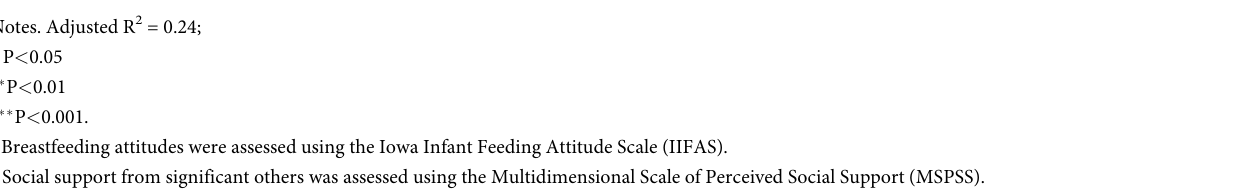
Baby had trouble sucking or latching on onto the breast Not producing enough milk Milk taking too long to